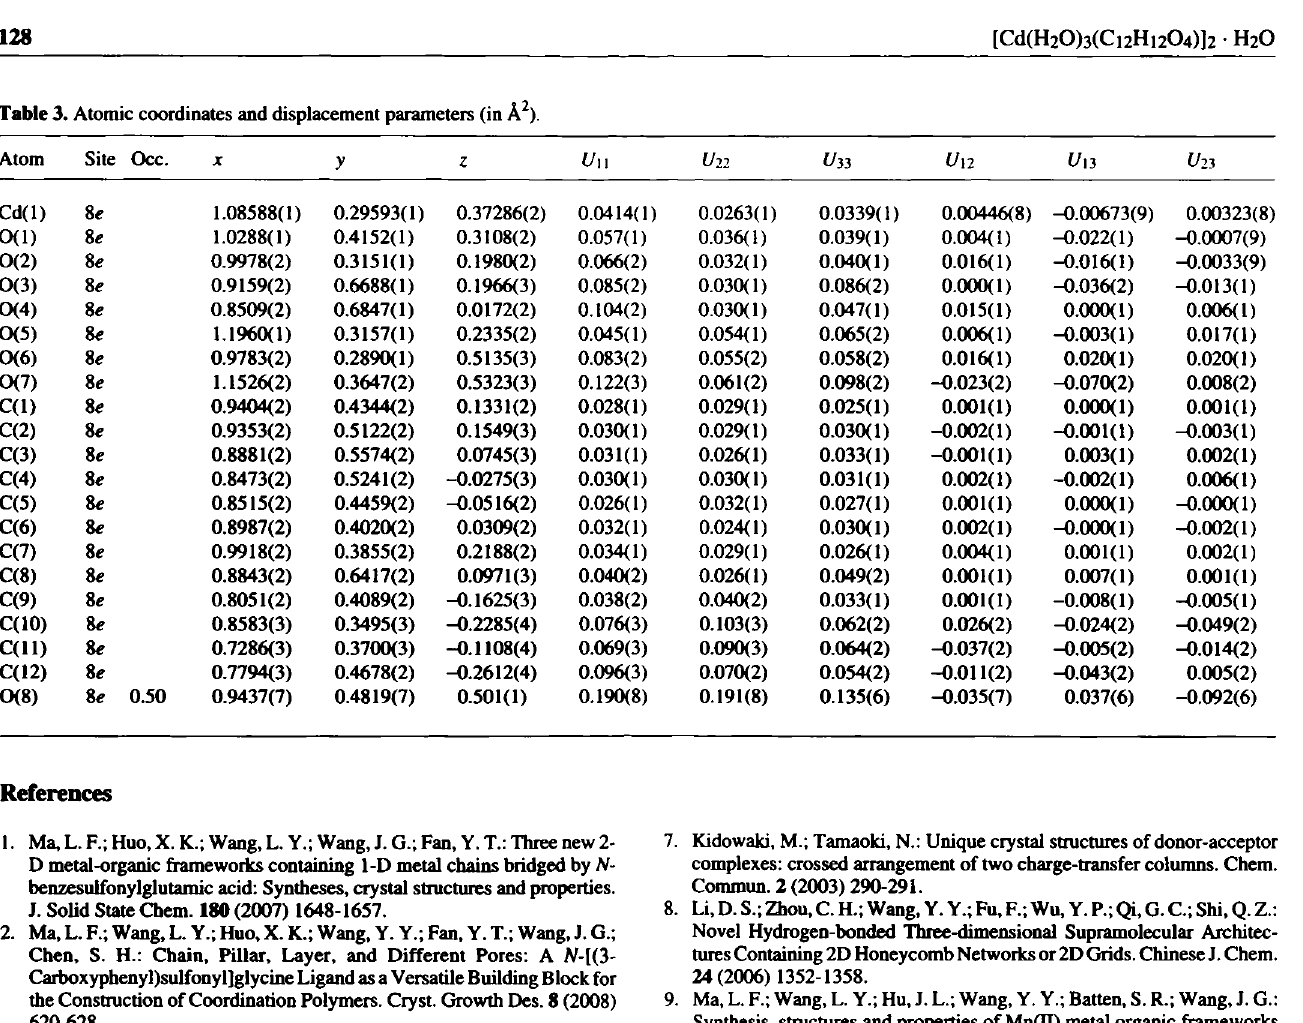
Table 3. Atomic coordinates and displacement parameters (in Â 2